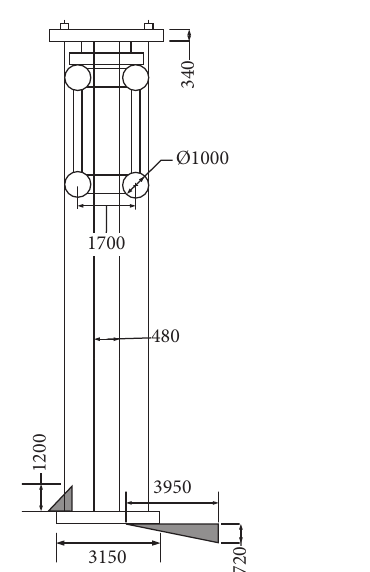
Figure 16: Elevation of the temporary suspender system.